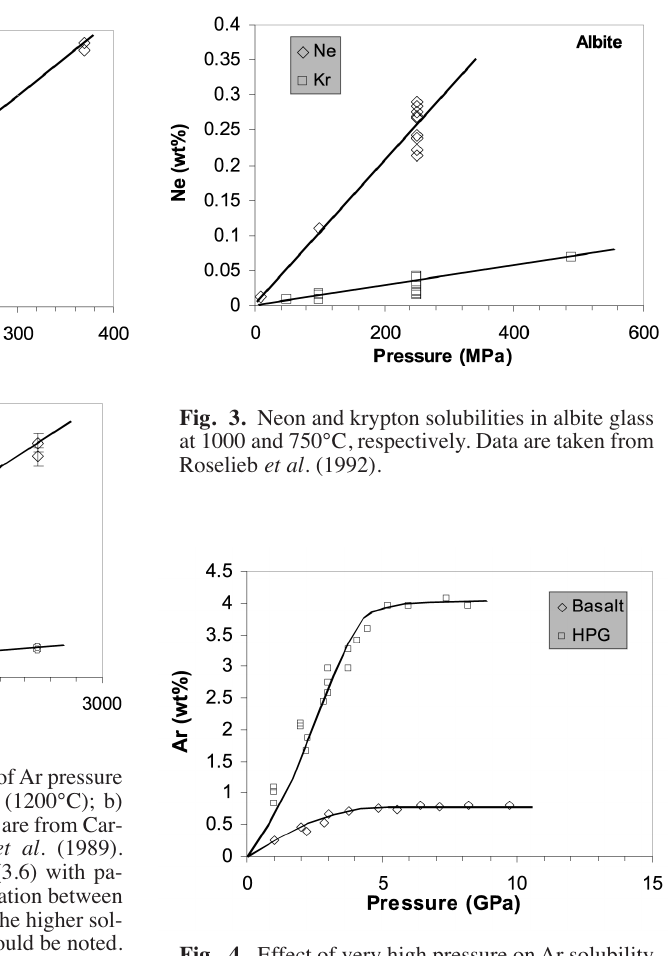
Fig. 4. Effect of very high pressure on Ar solubility in basaltic and haplogranitic melts between 1500 and 2000°C. Data from Schmidt and Keppler (2002); curves calculated by using eq. (3.6) with the param- eters given by the authors (see table I). At about 5 GPa, dissolved Ar in the melt reaches a threshold concentration which does not increase even when Ar pressure is increased by some